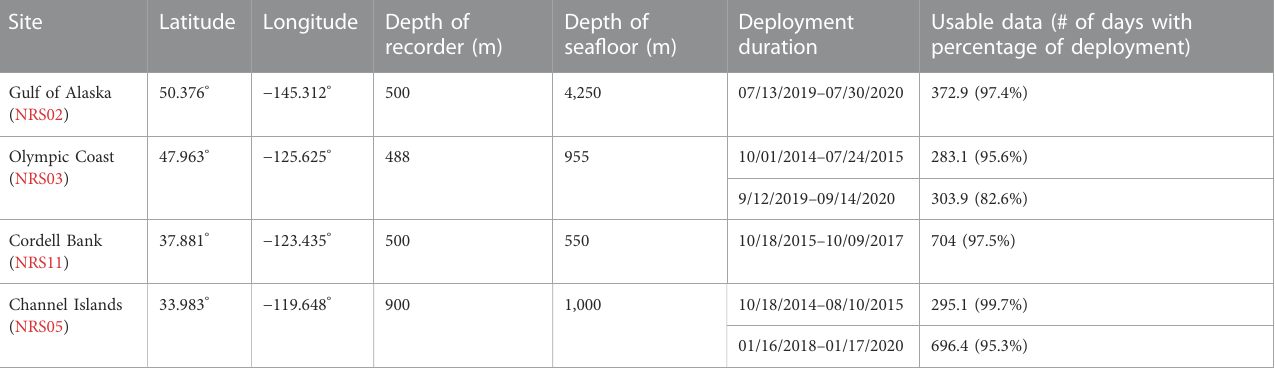
TABLE 1Deployment details at each recordingsite,including location, recorder and sea fl oor depth, deployment start and end, andnumber of days and percentage of the deployment with usable data. Site Usable data (# of days with